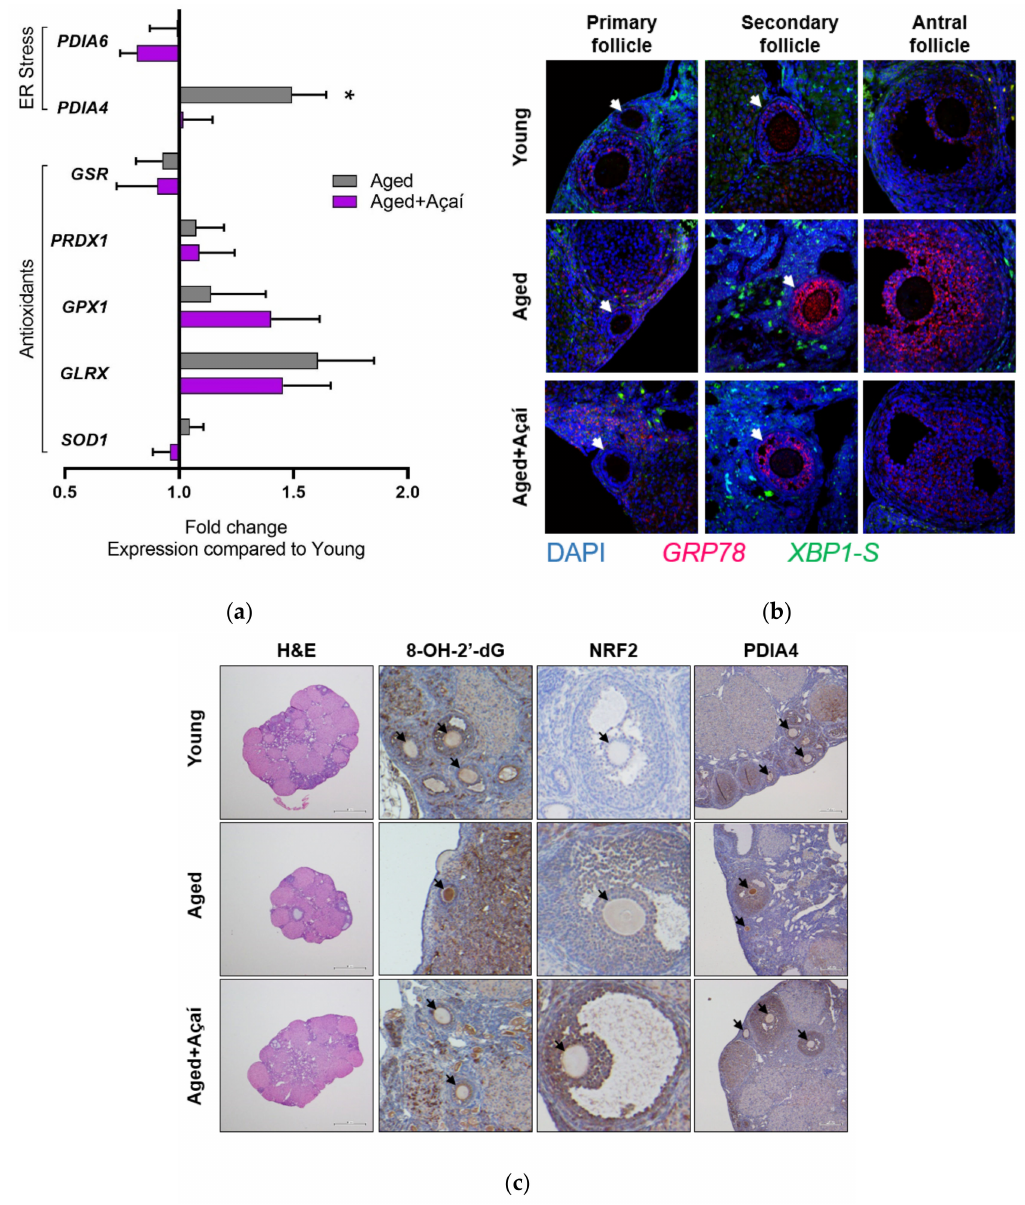
Figure 4. Biochemical changes in the ovary. ( a ) Whole-ovary gene expression of ER stress and antioxidant-related genes (n = 10 mice per group). ( b ) RNA in situ hybridization of ovarian sections (n = 5 mice per group). ( c ) Immunohistochemistry of ovarian sections for the localization of DNA damage marker 8-OH-2 (cid:48) -dG and proteins NRF2 and PDIA4 (n = 5 mice per group). The black arrows indicate oocytes. Scale bars: 1 mm for the HE images and 200 µ m for the IHC images; all of the IHC images are presented at the same magnification. The gene expression data were analyzed by ordinary one-way ANOVA with Tukey’s multiple comparisons when the overall effect p < 0.05. * p < 0.05 compared to young